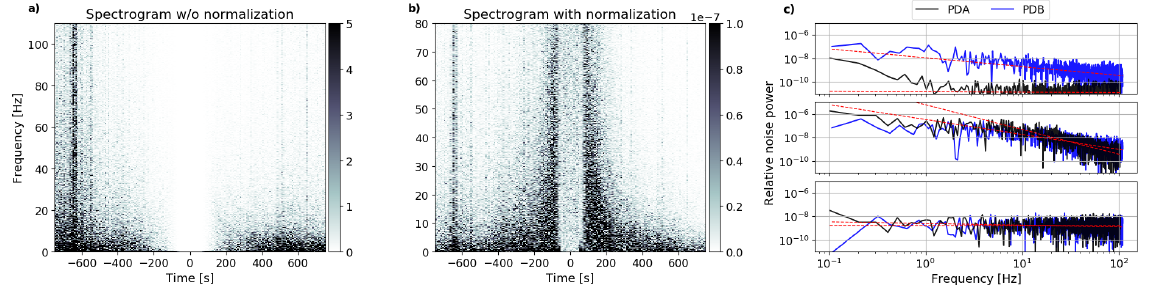
Figure 2: Spectrograms and Power spectra at three different moments of the Eclipse. a) Spectrogram of PDB signal, without any normalization. b) Spectrogram of PDB, with the signal normalized. c) Normalized power spectra in log-log scale calculated for N = 2048 points of PDA (blue) and PDB (black) at 550 s, 150 s and 0 s before totality. Linear fits to the are showed (red dashed), used to calculate the exponents for noise decay as in Fig. 3b. Noise power is calculated for each normalized chunk by computing the discrete Fourier transform and taking the square of its absolute